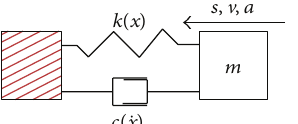
Figure 5: Nonlinear spring and damper model.